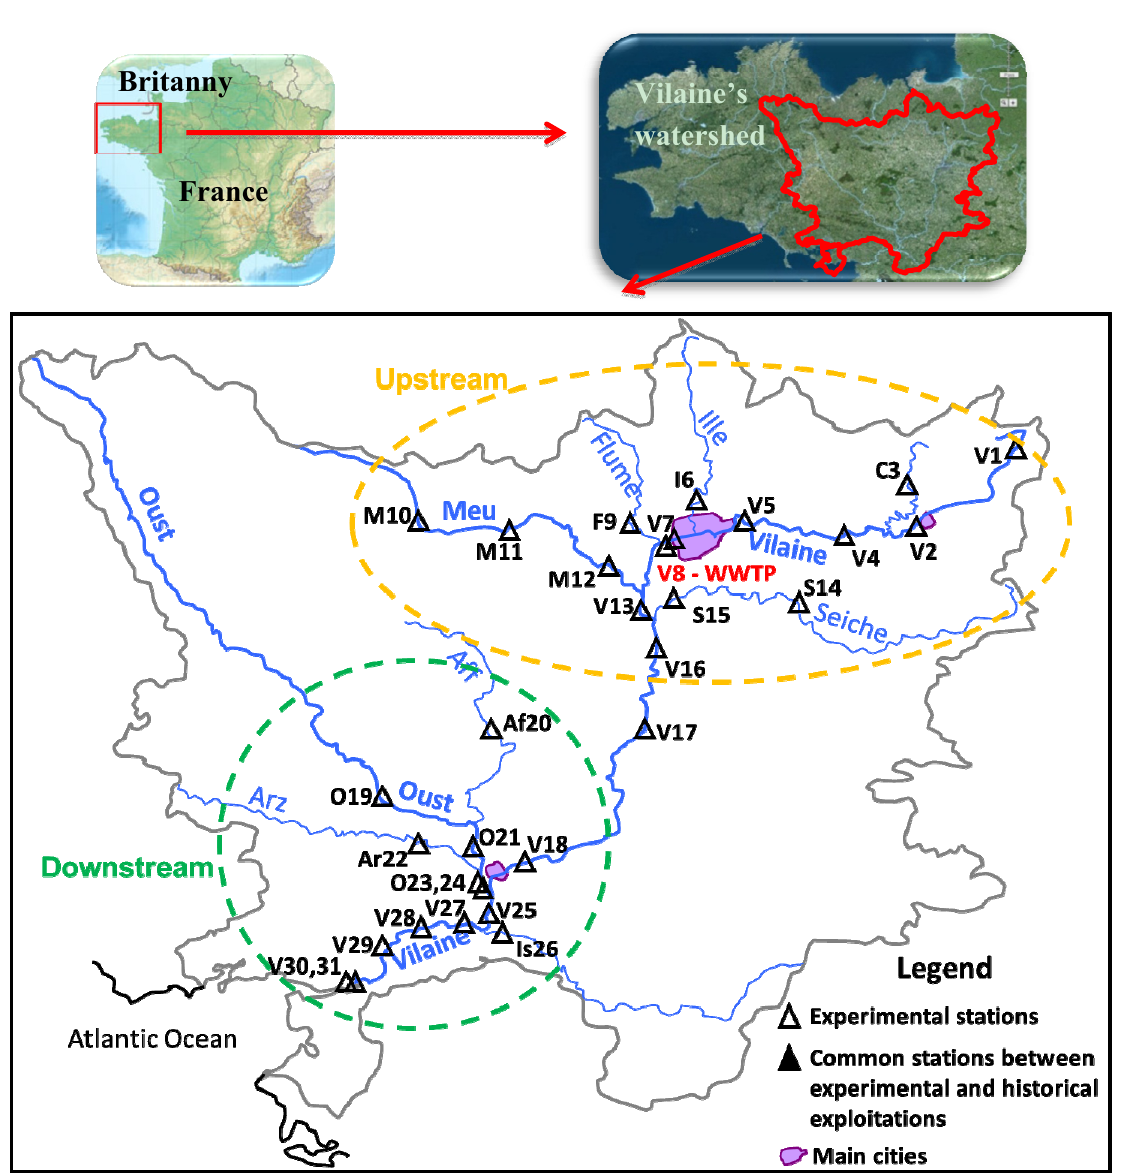
Figure 1. Location of